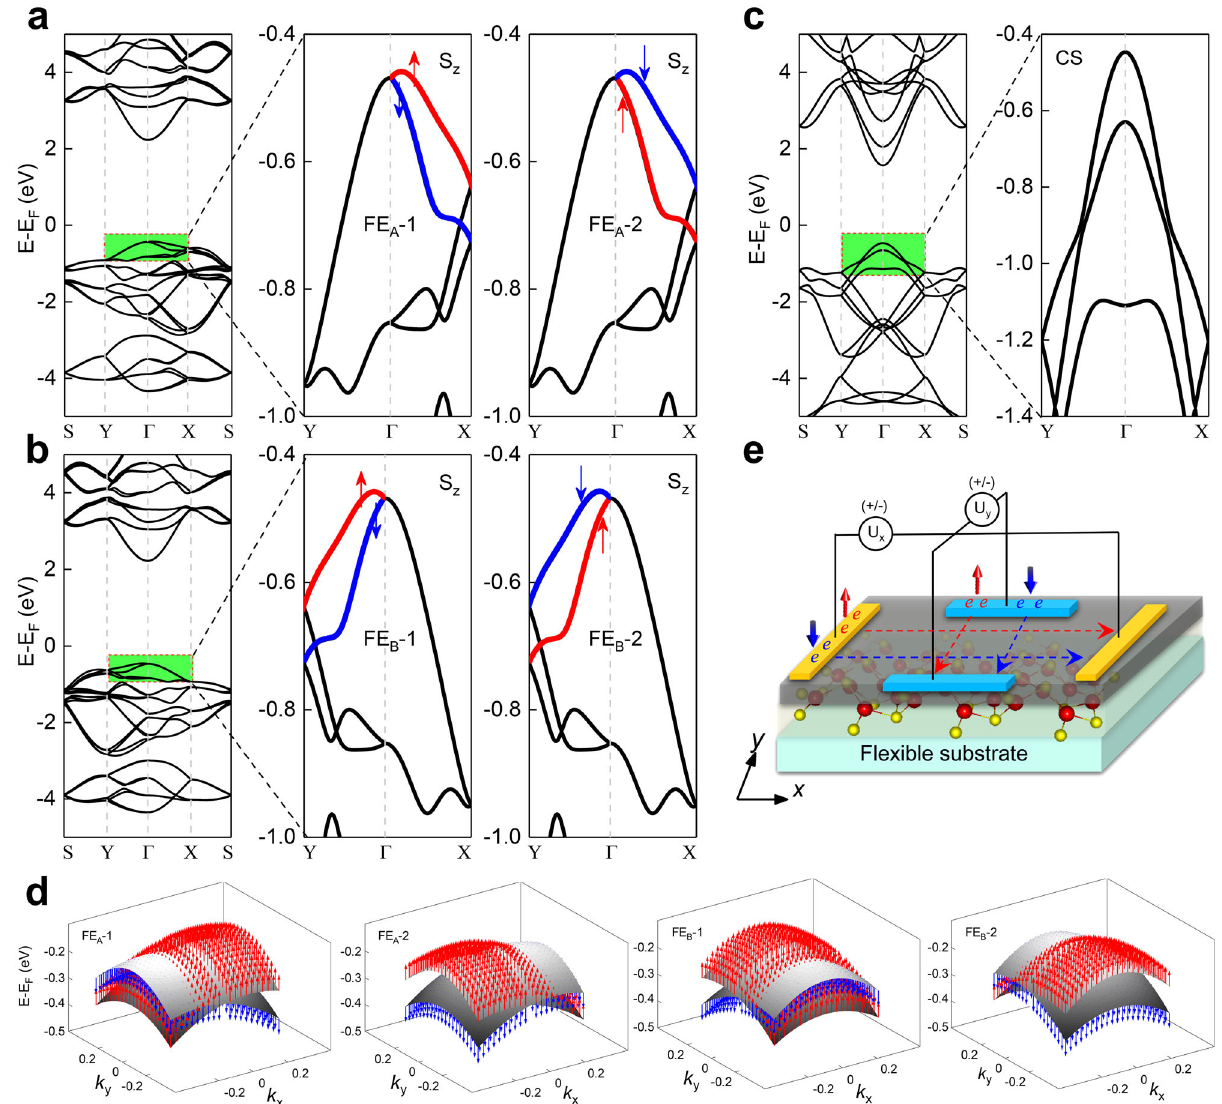
Fig. 6 Switchable anisotropic spin splitting. a , b Electronic band structure with SOC for FE A/B -1/2 ZnSe, in which the spin-split bands around VBM region are highlighted. The splitting bands along Γ -Y/X (spin degenerate/splitting) and Γ -X/Y (spin degenerate/splitting) high-symmetry lines around VBM for FE A/B phases indicate the anisotropy fl ipping feature during the FC phase change process. The spin-up and -down property is inversed accompanied by the FE-1/2 phase change, in which the red and blue arrows indicate S z (up) and -S z (down) spin orientation in the momentum space, respectively. c Completely spin degenerated band structure for CS phase. d Switchable spin texture projected to the k space for the upper and lower bands of monolayer ZnSe around VBM, which is expected by reversing the